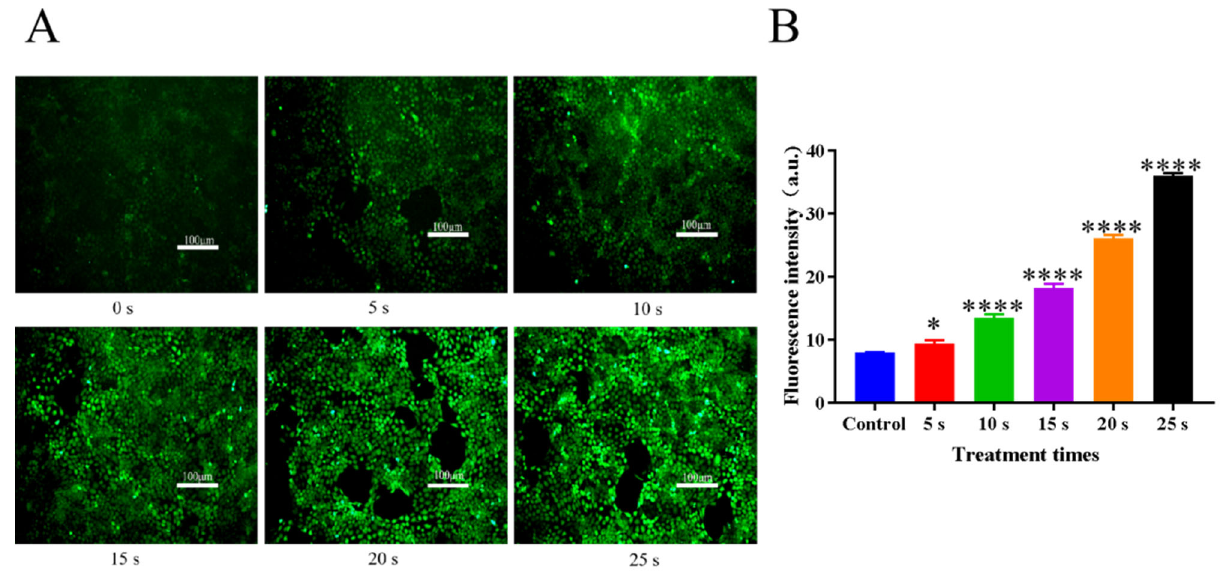
Figure 3. Intracellular ROS levels. ( A ) Fluorescence images of intracellular ROS generation in HaCaT cells. ( B ) The quantification by measuring fluorescence pixel intensity using Image J software. Data represent the mean ± SD of three independent experiments. * p < 0.05, **** p < 0.0001 with ANOVA compared with the control.